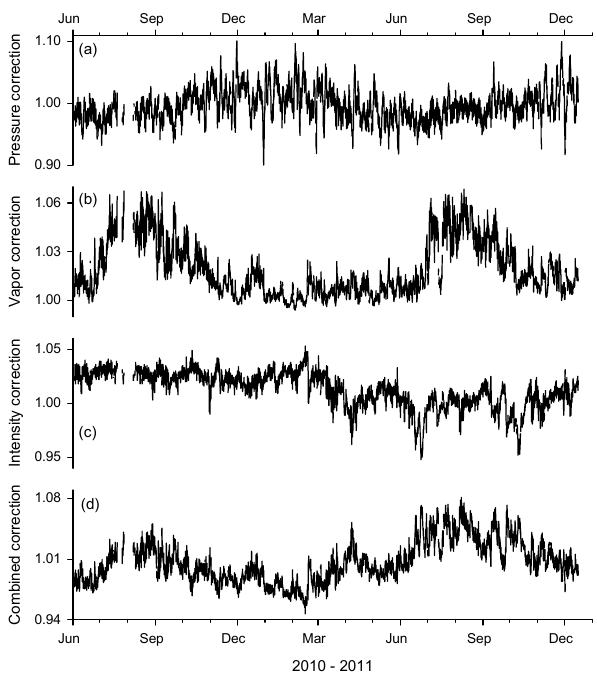
Fig. 11. Corrections for variations in pressure (a) , atmospheric wa- ter vapor (b) , the incident cosmic-ray neutron intensity (c) , and the combined correction (d) computed for the Santa Rita COSMOS site in Arizona. Published by Copernicus Publications on behalf of the European Geosciences